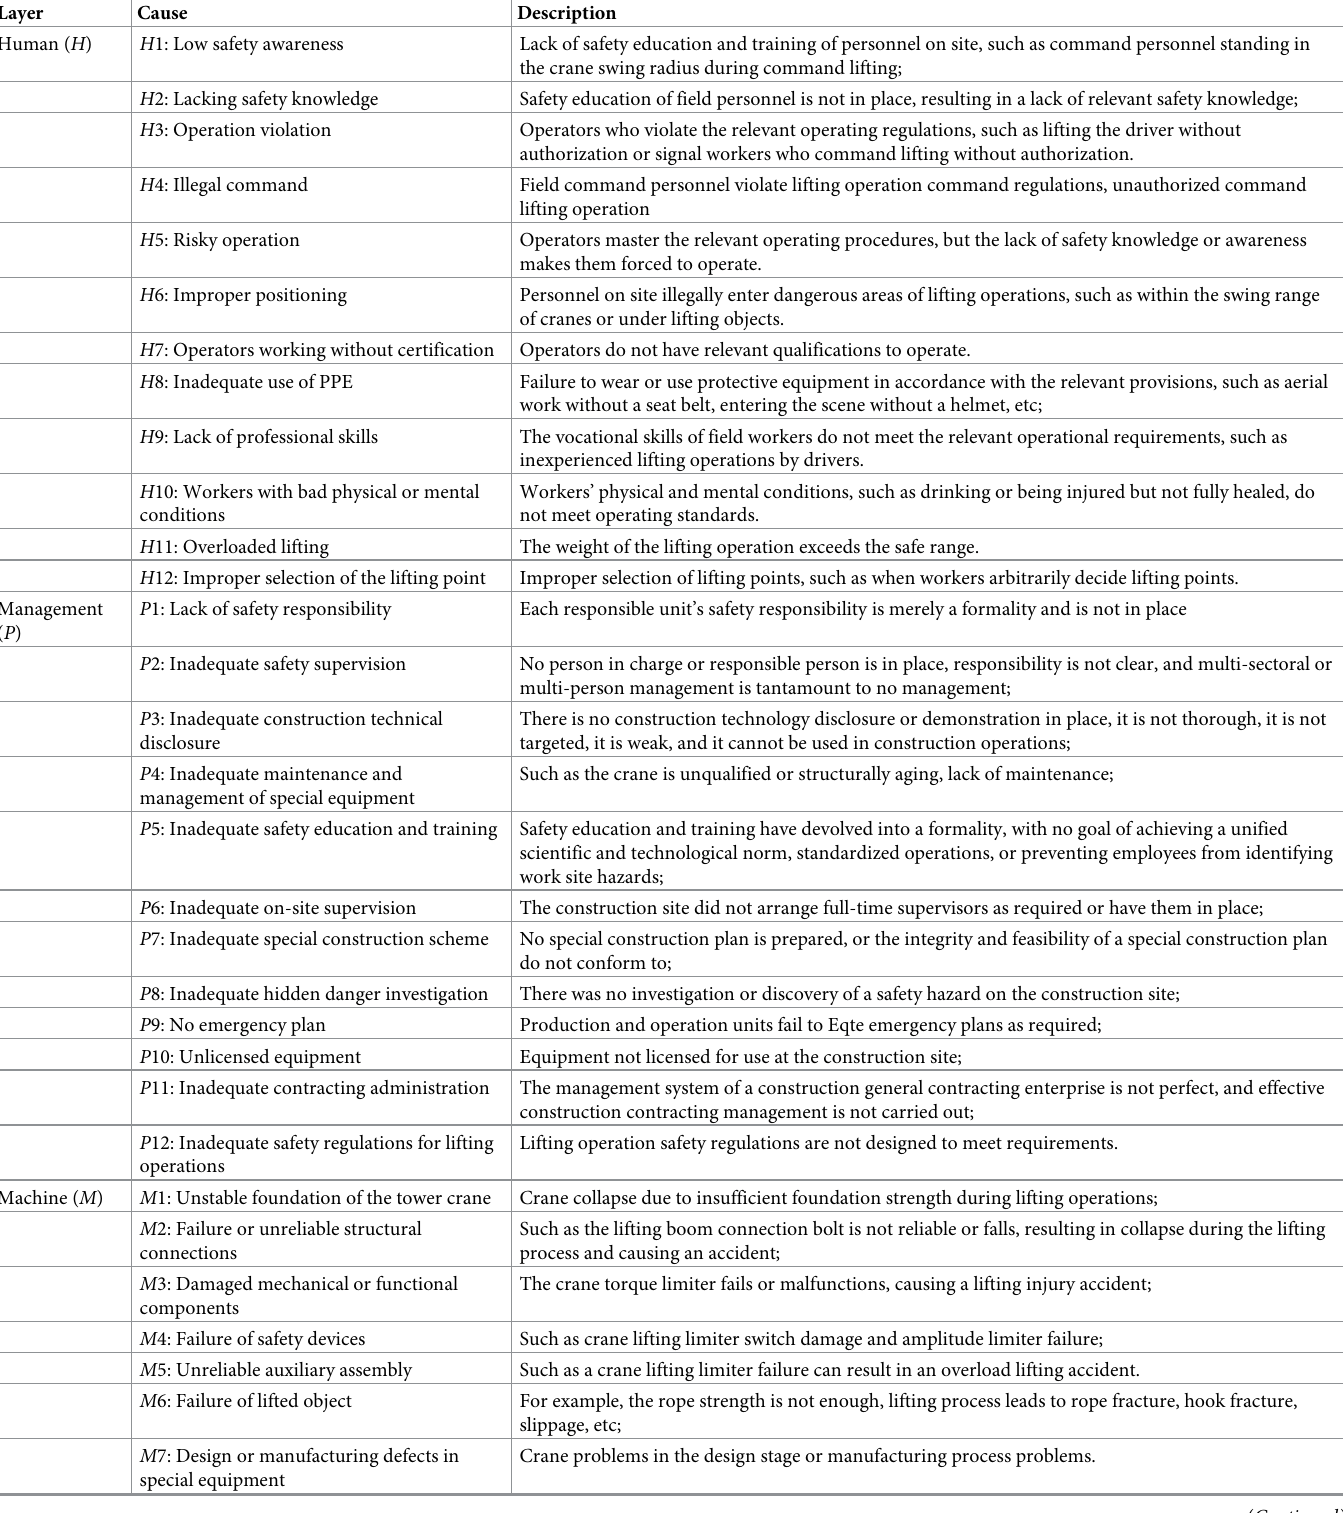
Table 1. Causes of lifting